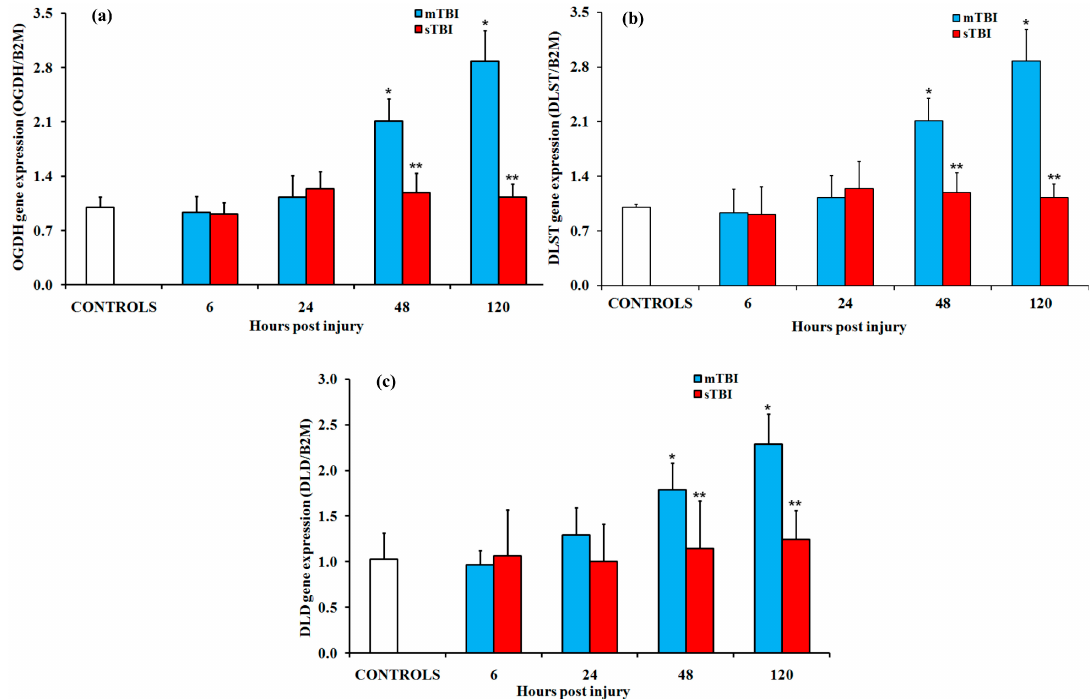
Figure 6. Changes in the expression of genes encoding for the di ff erent subunits of the oxoglutarate dehydrogenase (OGDH) complex in brain tissue homogenates of rats receiving a TBI of di ff erent severities (mTBI or sTBI) at various times post-injury. ( a ) OGDH, the gene encoding for the E1 OGDH complex subunit; ( b ) DLST, the gene encoding for the E2 subunit dihydrolipoamide-S-succinyltransferase; ( c ) DLD, the gene encoding for the E3 subunit dihydrolipoamide dehydrogenase. Values are the mean of six animals. Standard deviations are represented by vertical bars. Gene expressions were calculated relative to the expression of the housekeeping gene, β -2-microtubulin (B2M). * significantly di ff erent from the controls, p < 0.05. ** significantly di ff erent from the corresponding time of the mTBI rats, p < 0.05.